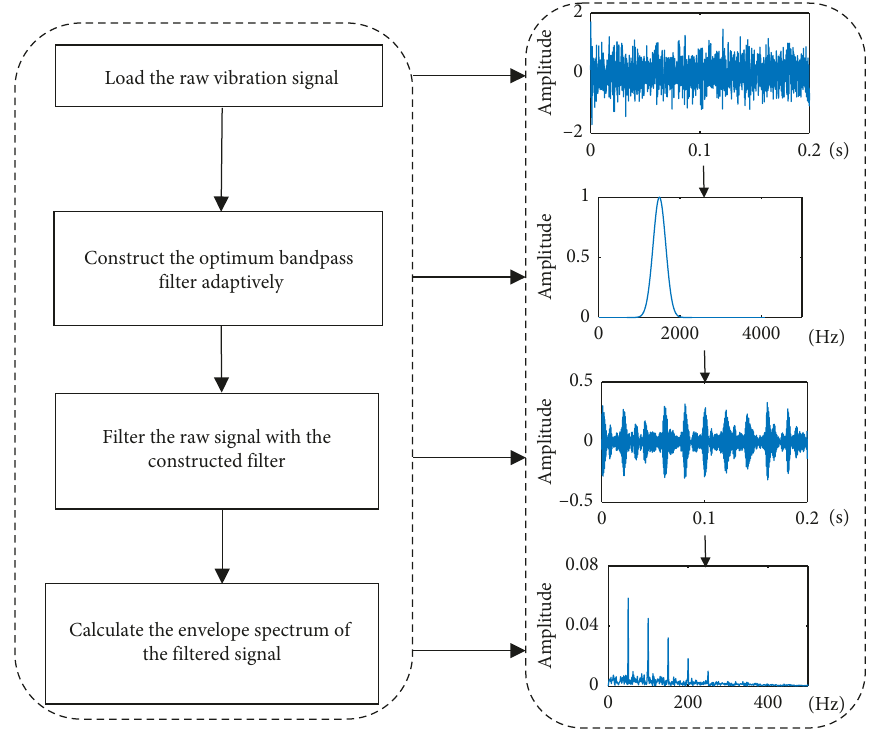
Figure 4: The diagnosis process of the proposed